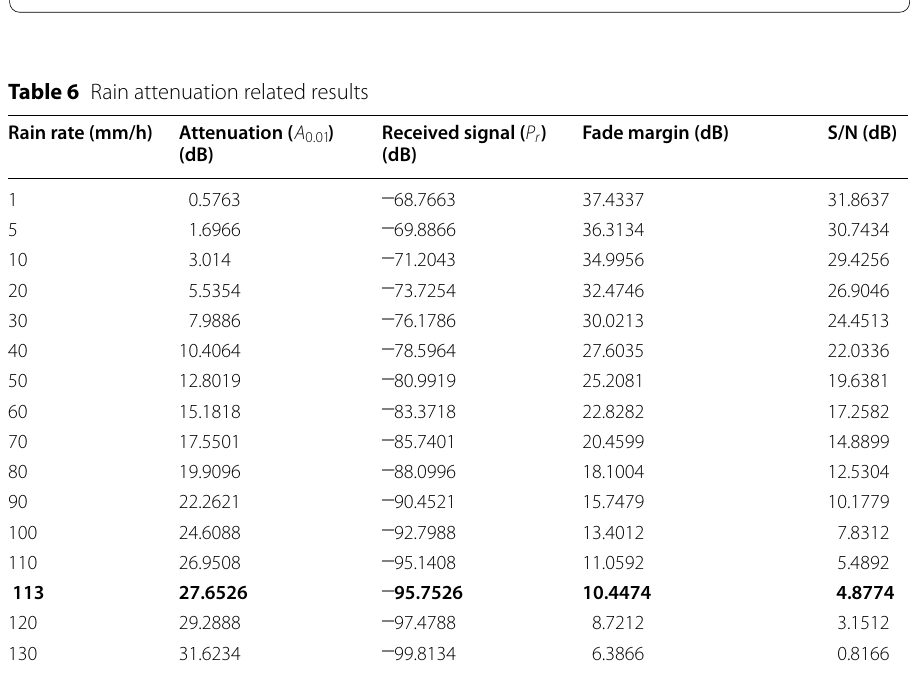
Bold values indicate the numbers obtained at the rain rate of exceedance for that particular area. Rain rate 113 mm/hr is the rain rate of exceedance (R 0.01